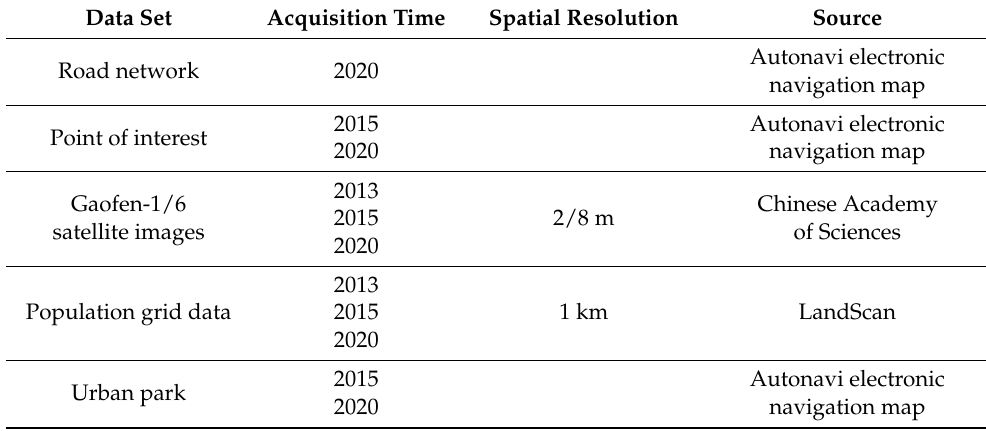
Table 2. Geospatial datasets used in this study.